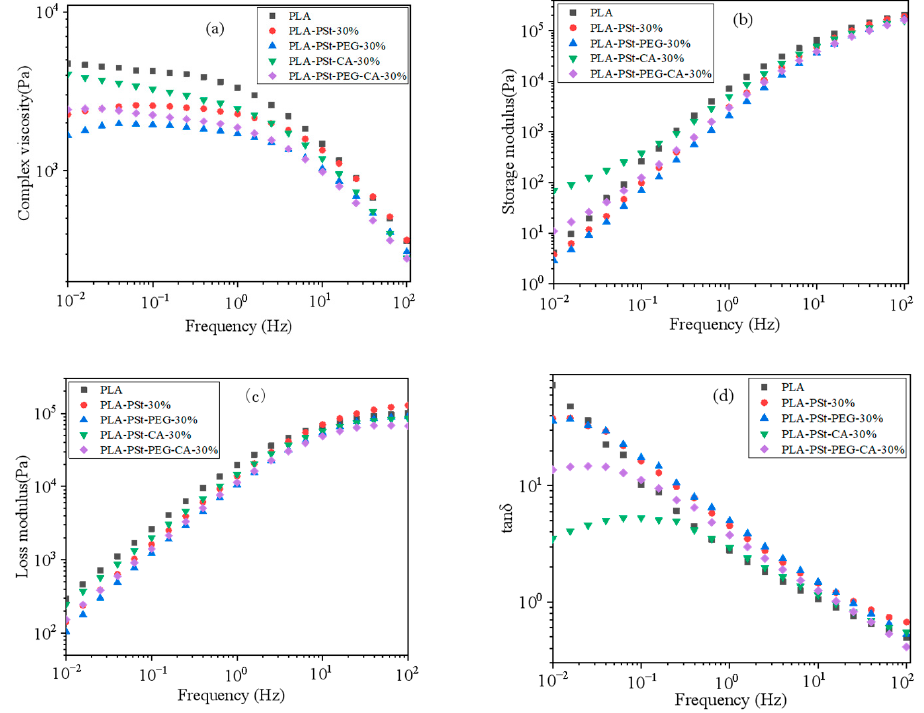
Figure 2. ( a ) Complex viscosity, ( b ) storage modulus, ( c ) loss modulus, and ( d ) loss tangent (tan δ ) of PLA and di ff erent blends with PSt ratios of 30 PLA and different blends with PSt ratios of 30 wt%.